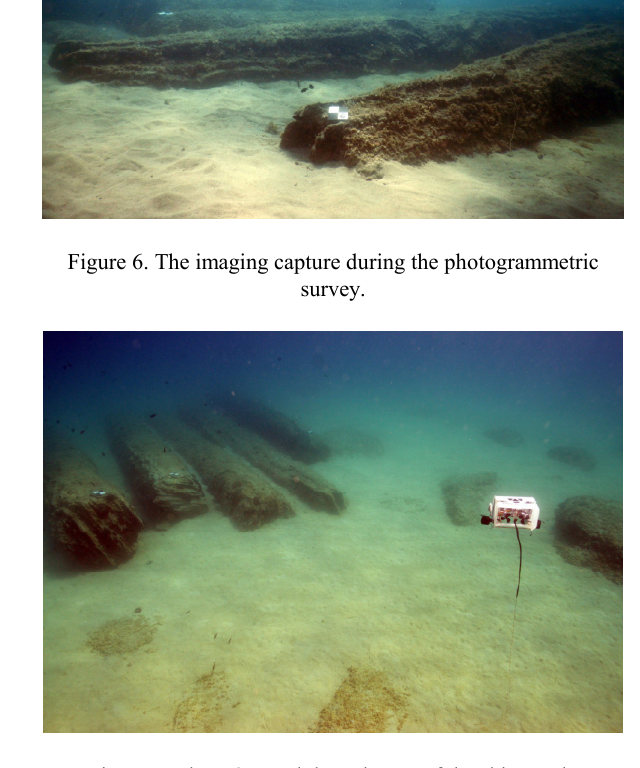
Figure 7. The ROV and the columns of the